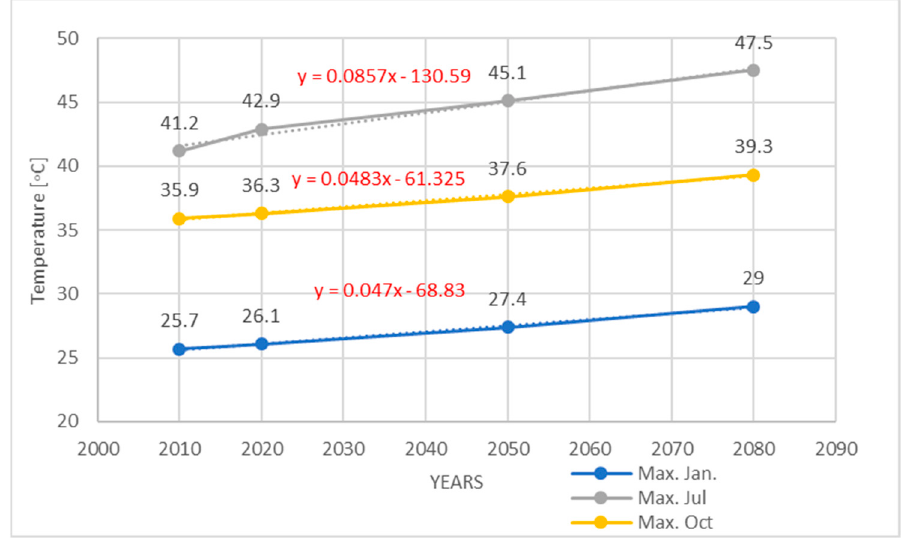
Figure 8. Maximum average daily temperatures for present and predicted weather in Hurghada.